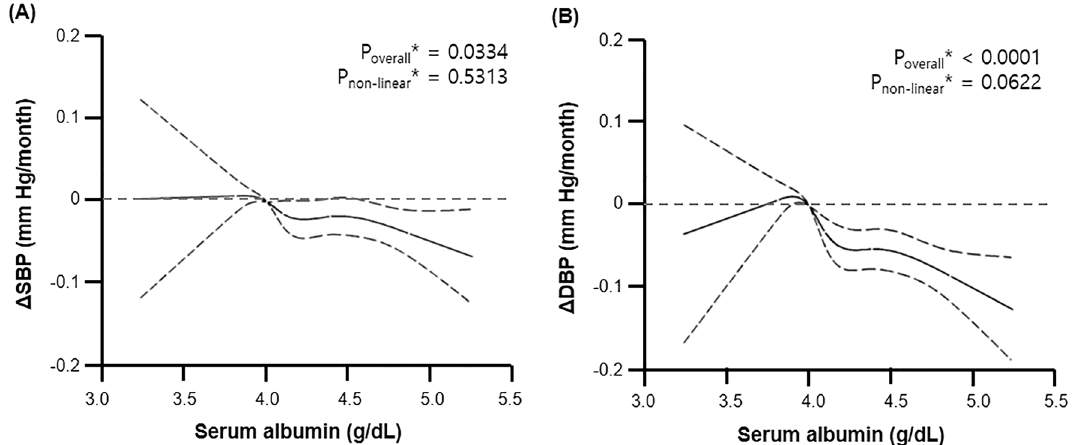
Figure 1. Relationship of serum albumin levels with the change in ( A ) systolic blood pressure (ΔSBP) and (B) diastolic blood pressure (ΔDBP) compared with the chosen reference albumin (g/dL) of 4.0. The solid line represents the change in BP during the follow-up period, and dashed lines represent 95% confidential intervals. *Calculated by restricted cubic spline regression using age, sex, and smoking history as